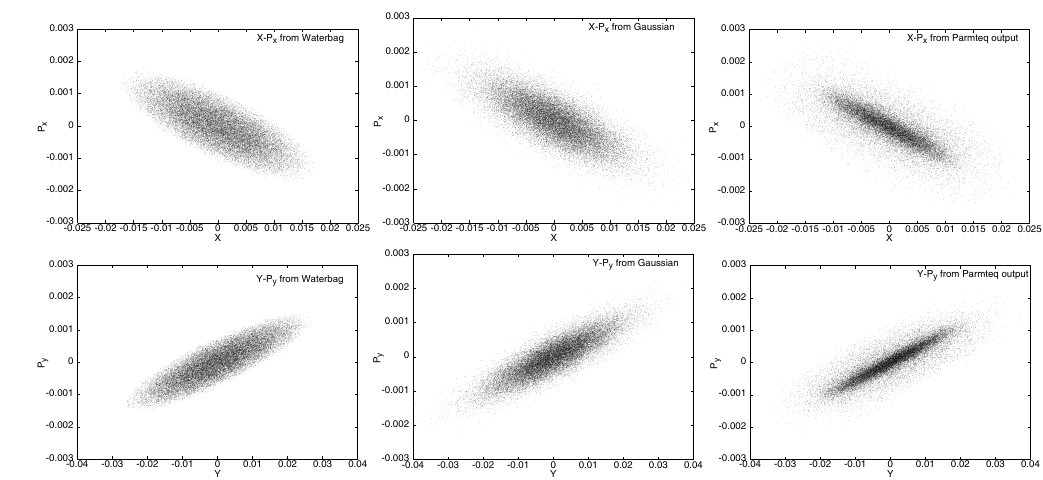
FIG. 2. Transverse phase-space projections from Waterbag, Gaussian, and the LEBT/RFQ distributions.